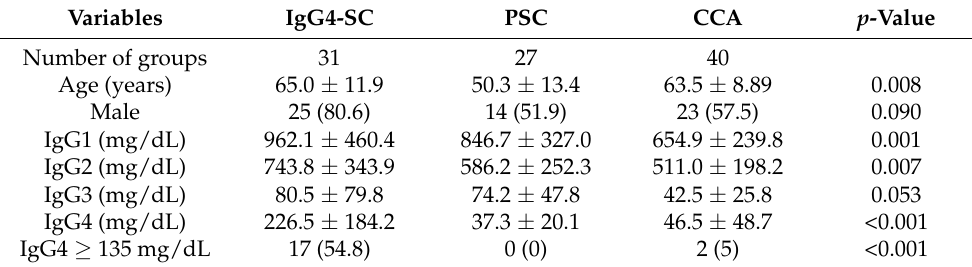
Table 1. Baseline